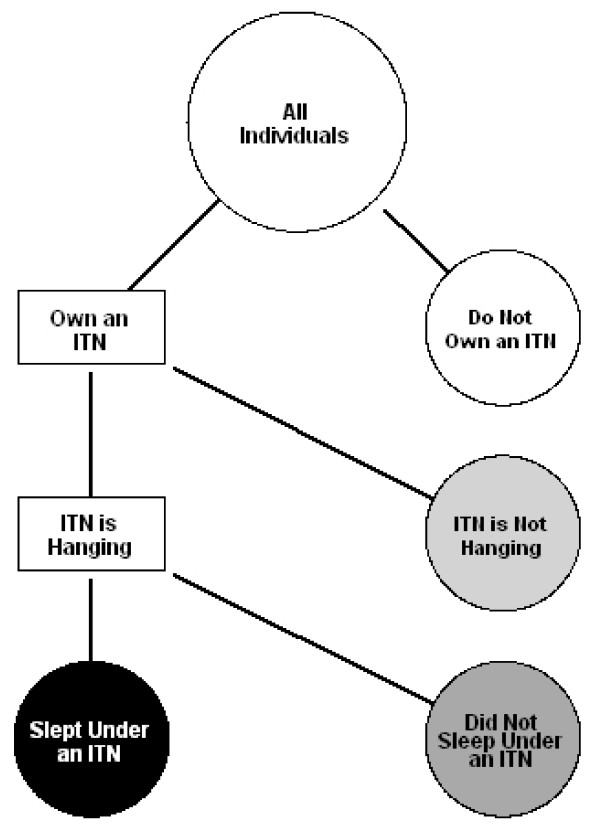
Flowchart representing the four categories of ITN use. ITN use categories are represented as circles. White: living in households with no ITN present; light grey: living in households owning but not hanging an ITN; dark grey: living in households that have an ITN hanging but are not sleeping under an ITN; and black: sleeping under an ITN.